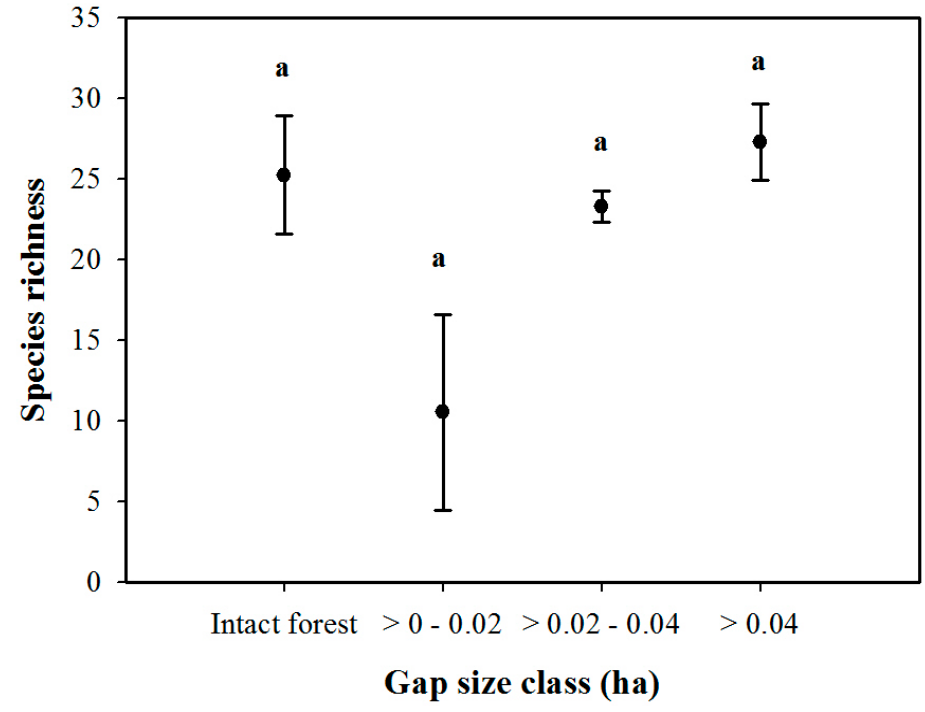
Figure 2. Understory vegetation species richness by harvest gap size (ha). All identified individual species encountered within all meter square sample plots were used to calculate richness. Error bars represent standard error. There were no significant differences between gap size classes ( p > 0.05).